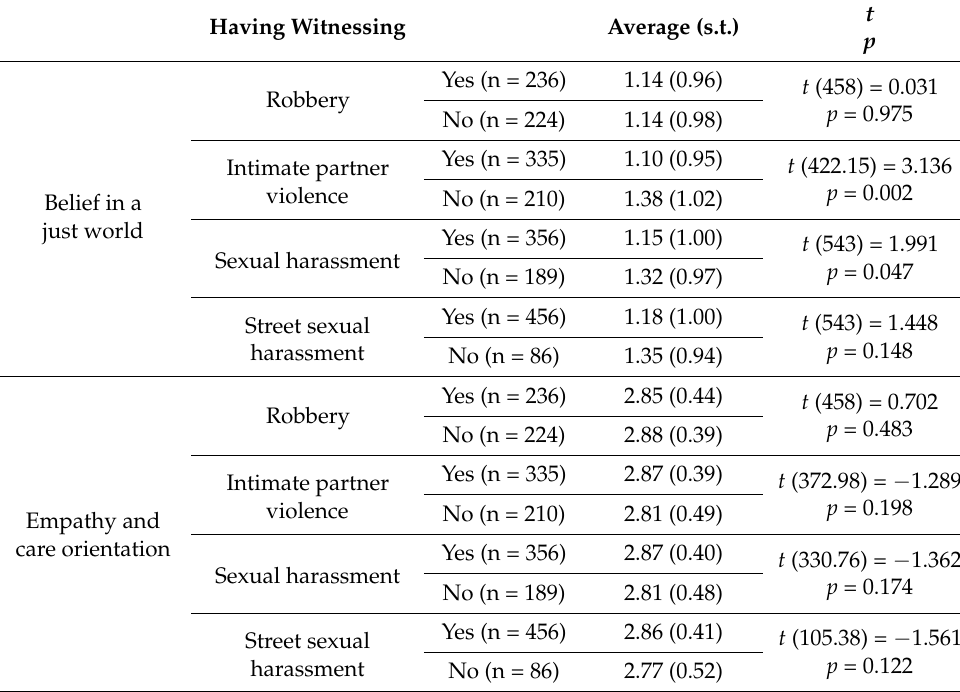
Table 4. Differences in characteristics of the people who help by experiences as violence witness. Having Witnessing Average